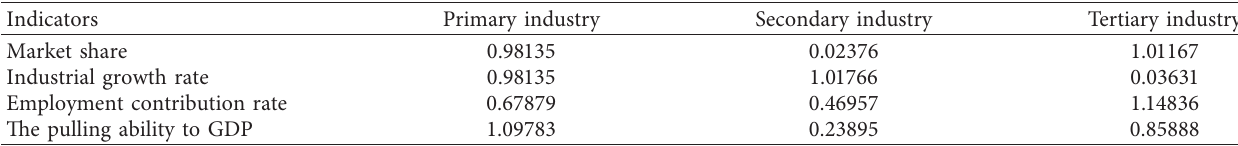
Table 9: Summary of standardized data on indicators of three major industries.